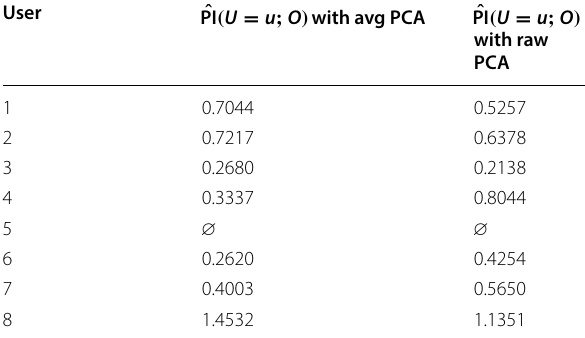
Table 2 Estimated PI values with maximum profiling